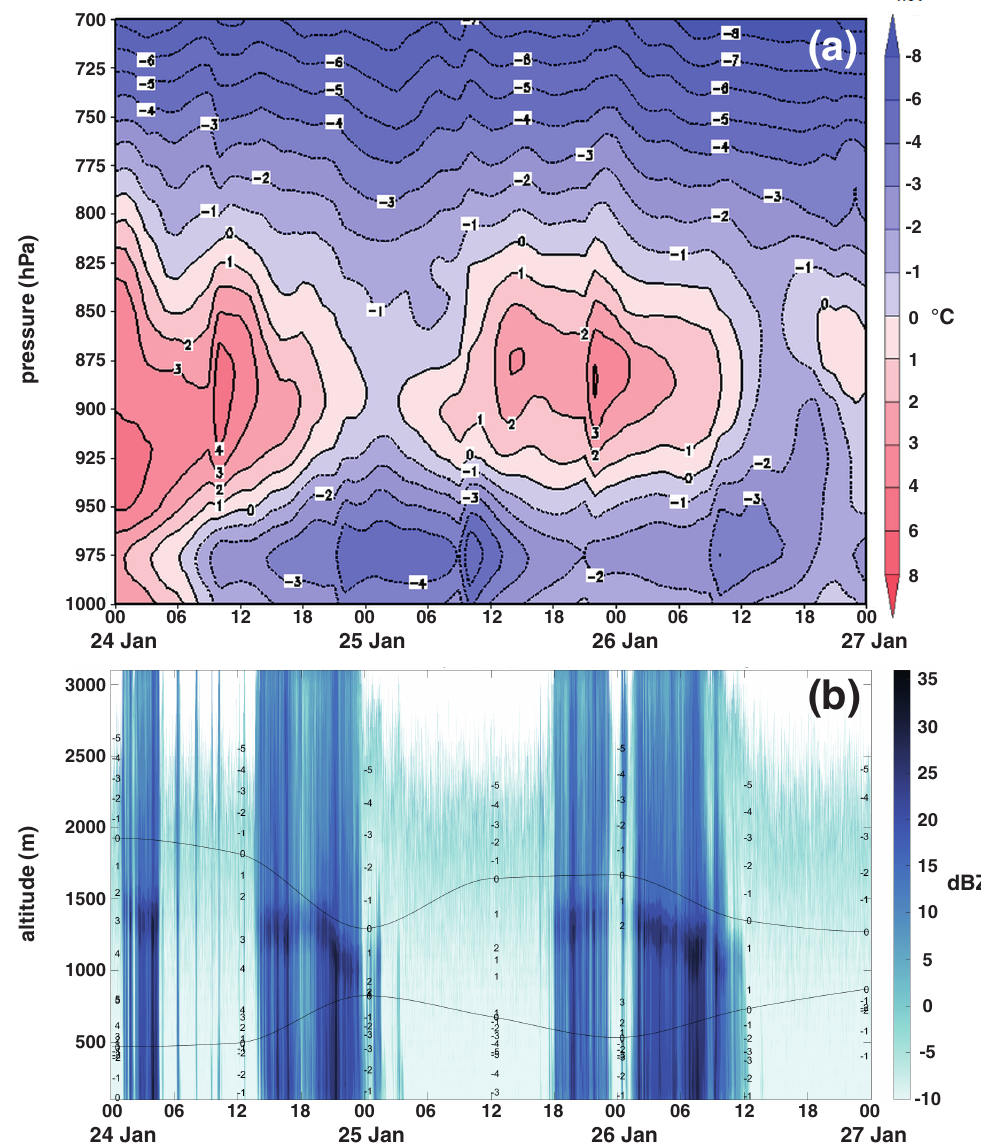
Figure 5. ( a ) Time series of temperature profiles between 24–26 January 2019 from ERA5 (shaded according to the scale, as in Figure 3a–c). ( b ) Micro Rain radar attenuated reflectivity (dBz) observations from M˘agurele during the same period as in ( a ). Temperature profiles from the Bucharest sounding at 00 and 12 UTC are overlapped with the radar reflectively, the black contours separating positive and negative temperature